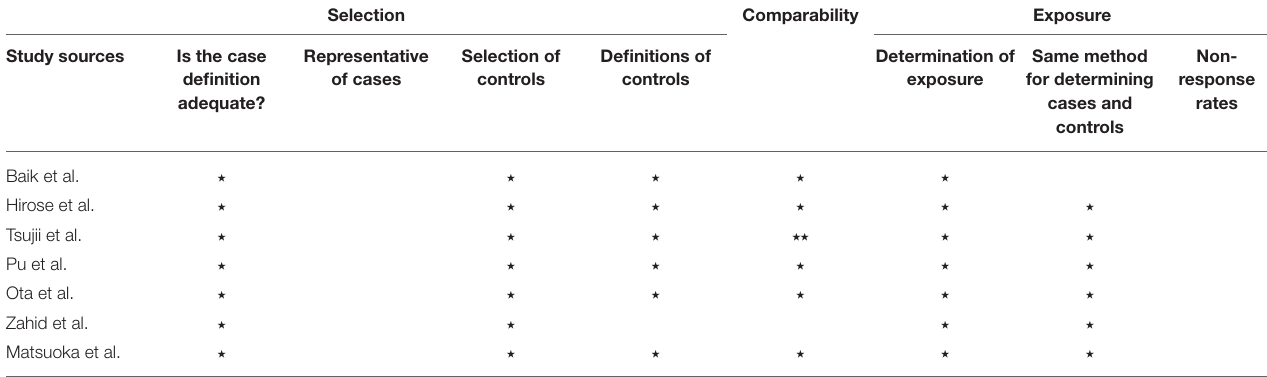
TABLE 1 | Risks of bias within studies